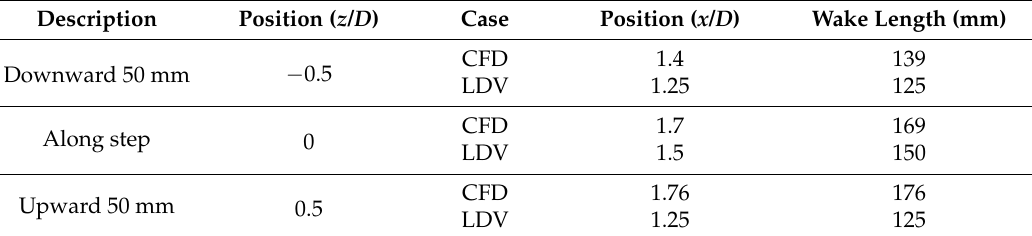
Table 2. Wake length behind the step cylinder.